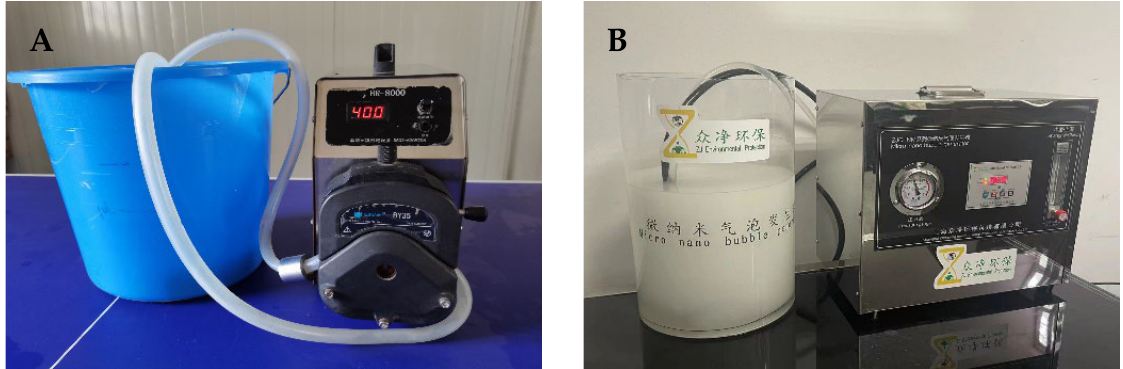
Figure 1. The preparation of magnetized water ( A ) and oxygenated water ( B ).